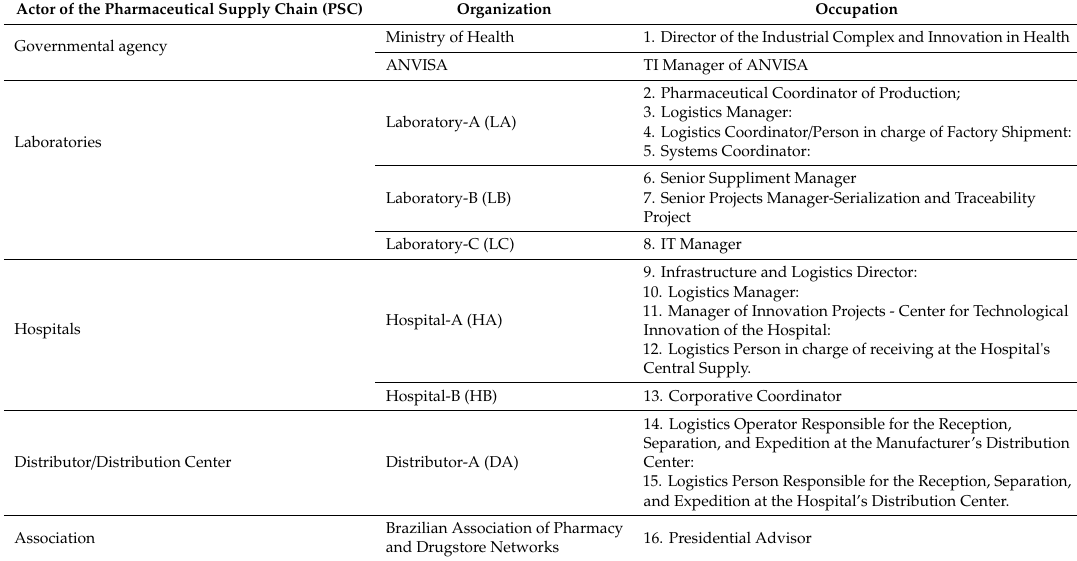
Table 4. Profiles of questionnaire respondents. ANVISA—National Agency of Sanitary Vigilance Actor of the Pharmaceutical Supply Chain